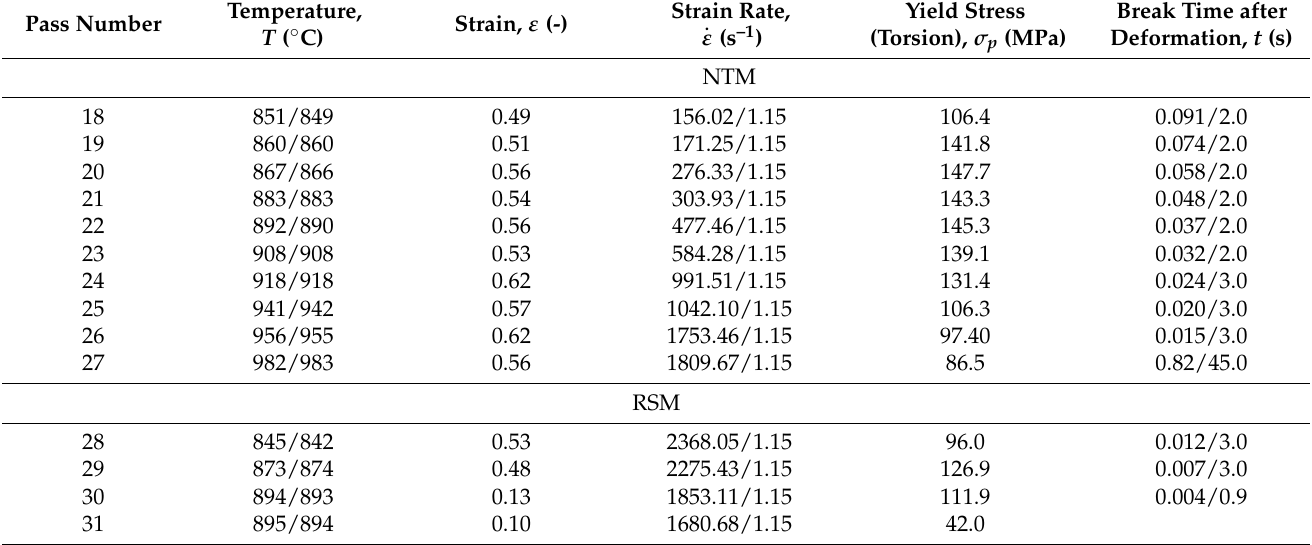
Table 3. Parameters of the deformation process during physical modelling of rolling a 20MnB4 steel wire rod with a diameter of 5.5 mm in NTM and RSM blocks of a wire rod rolling mill (test variant V1)